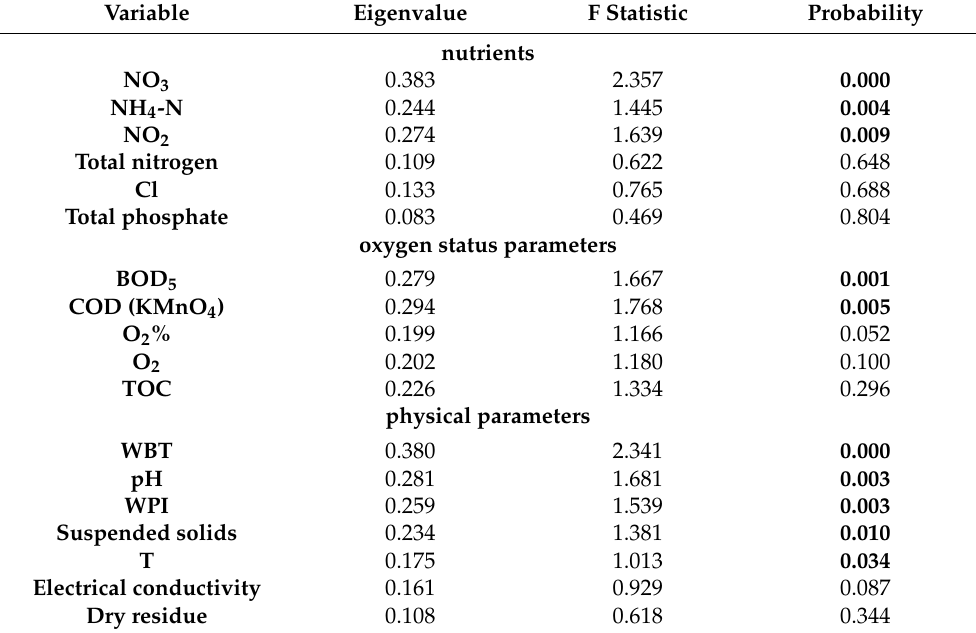
Table 3. Results of the forward selection analysis.